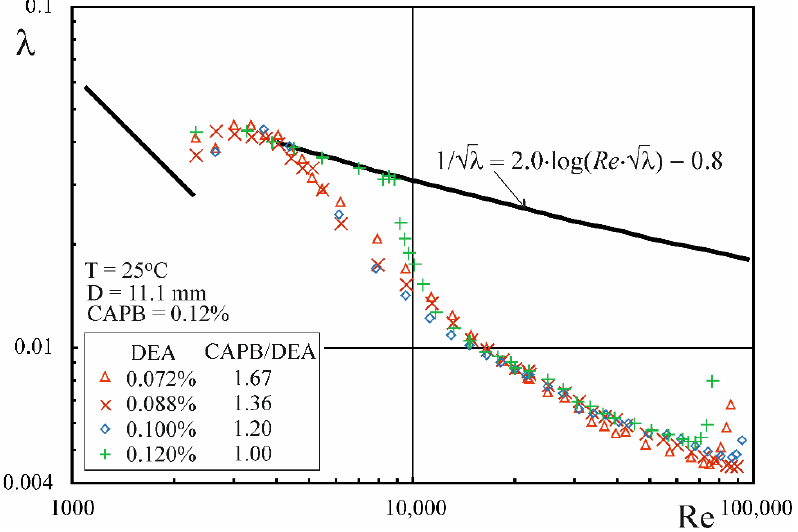
Figure 3. Friction factor versus solvent Reynolds number for CAPB/DEA solutions (0.09%/0.075%; D = 11.1 mm) in the range of temperature from 3 to 15 °C ( a ) and from 20 to 45 °C ( b ).